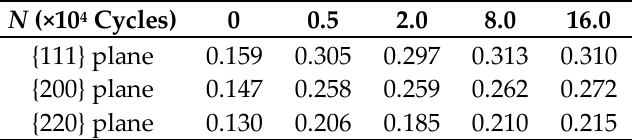
Table 1. Change of average value of total misorientation, β ave